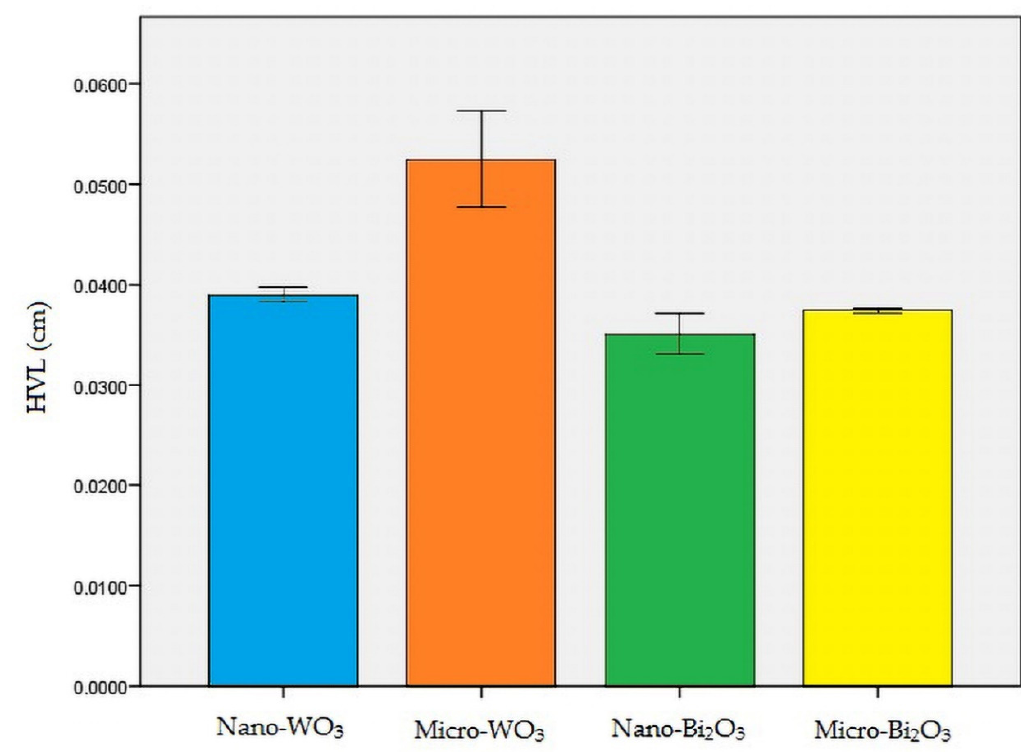
Figure 6. Half-value layer (HVL) of all the